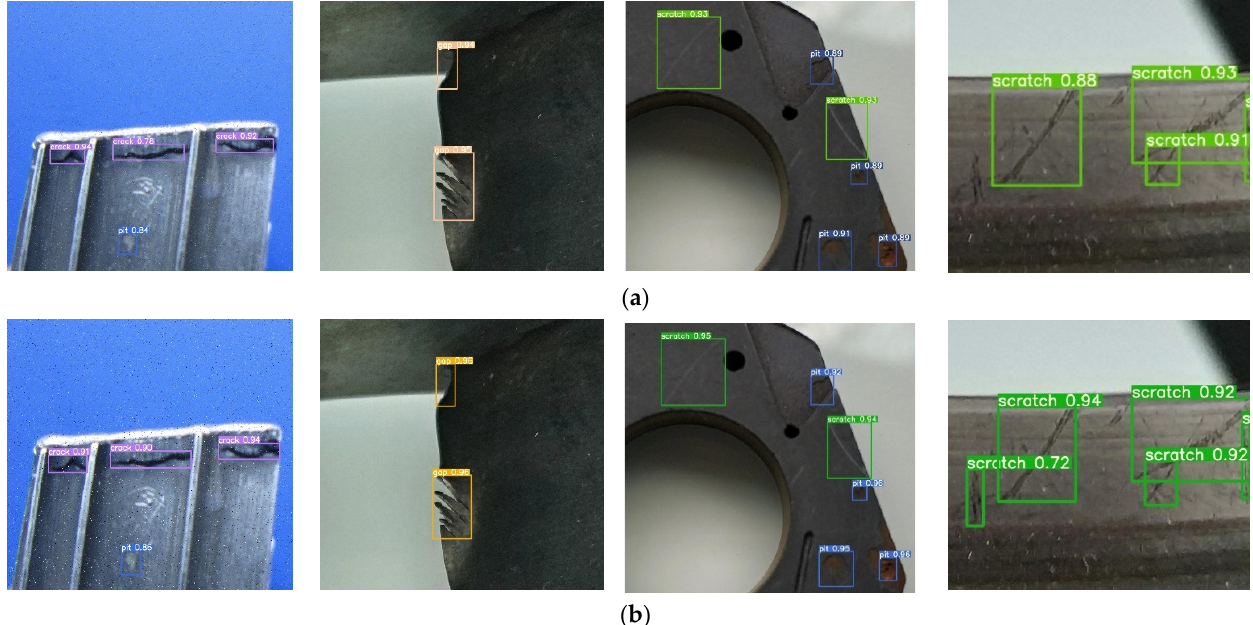
Figure 7. Comparison of detection effects of two models. ( a ) Original YOLOv5s model; ( b ) YOLOv5s-KEB model.